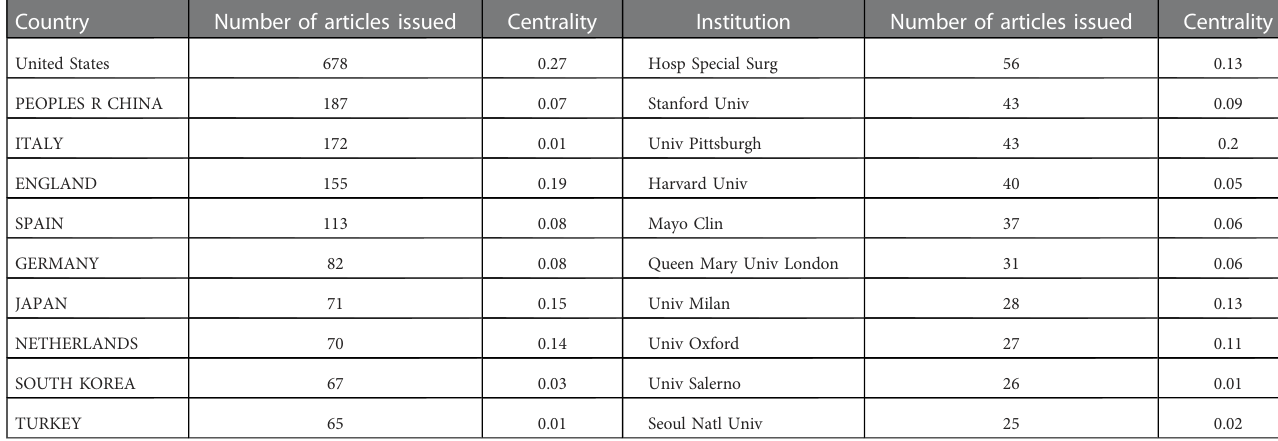
Country Number of articles issued Centrality Institution Number of articles issued Centrality United States 678 0.27 Hosp Special Surg 56 0.13 187 0.07 Stanford